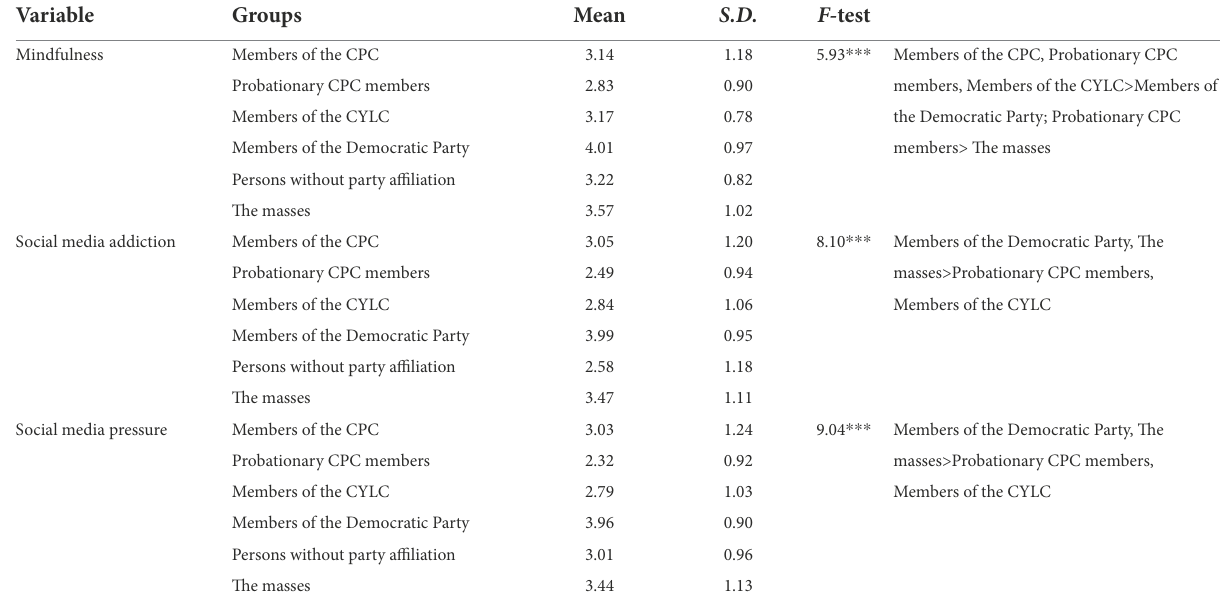
TABLE 5 Univariate ANOVA results.